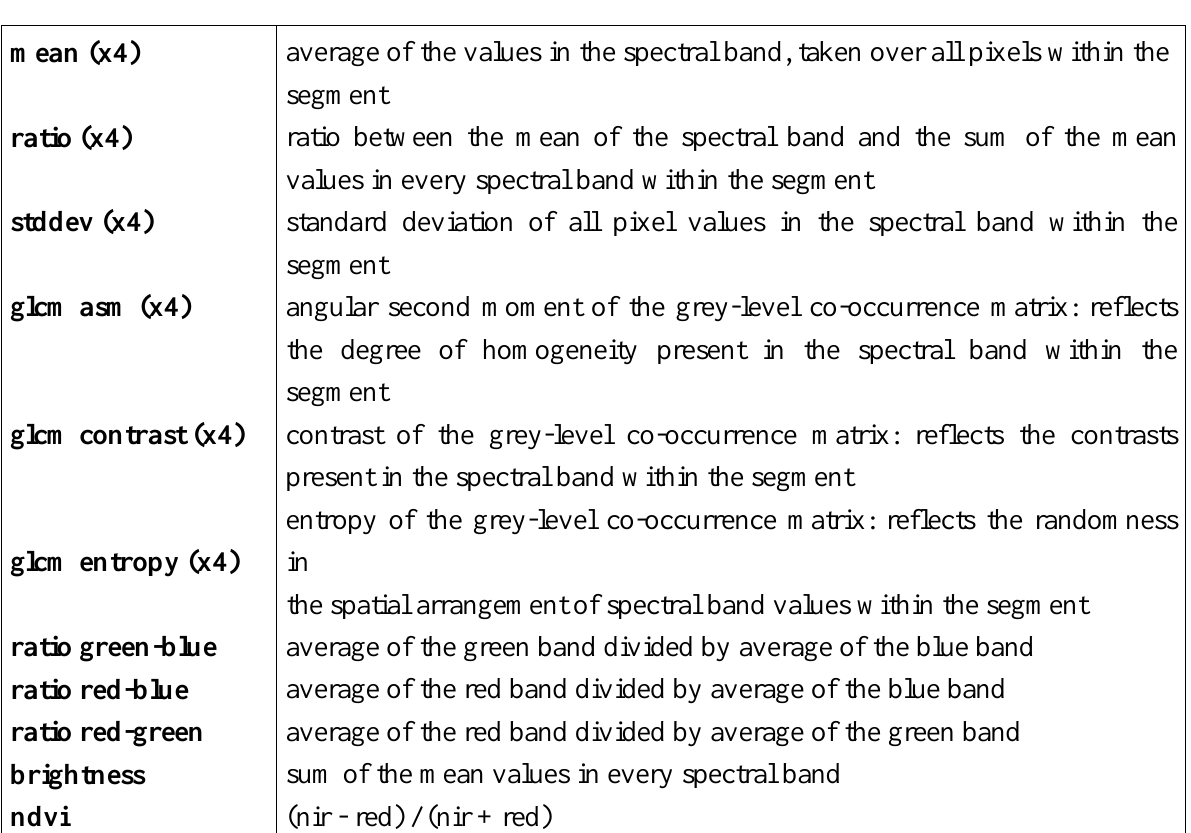
Table 2. Overview of the 29 spectral and textural variables used as input for the variable selection in each step of the DT and MLP classification